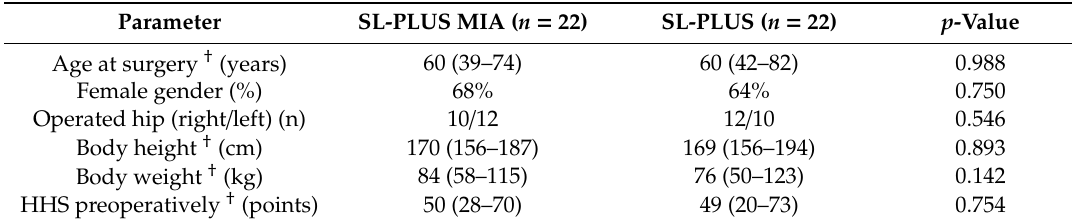
Table 1. Demographic data of the study group (SL-PLUS MIA, n = 22) and the control group (SL-PLUS, n = 22).